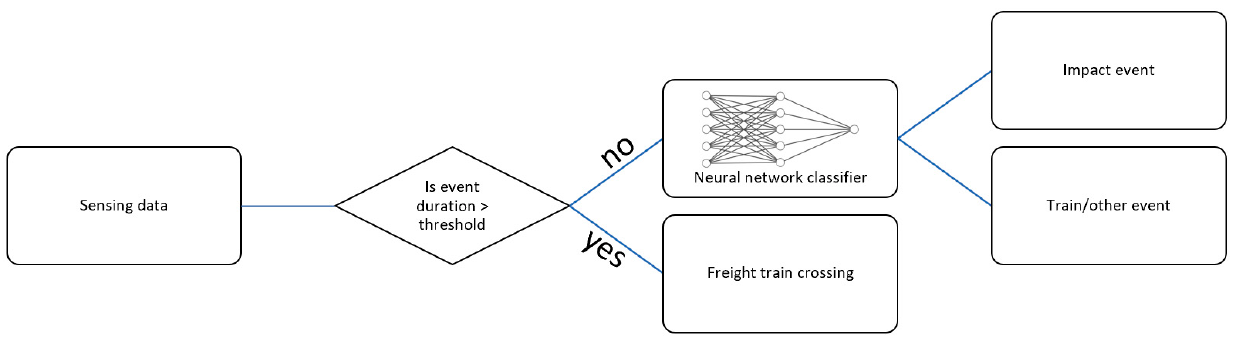
Figure 6. Algorithm for event classi fi cation.